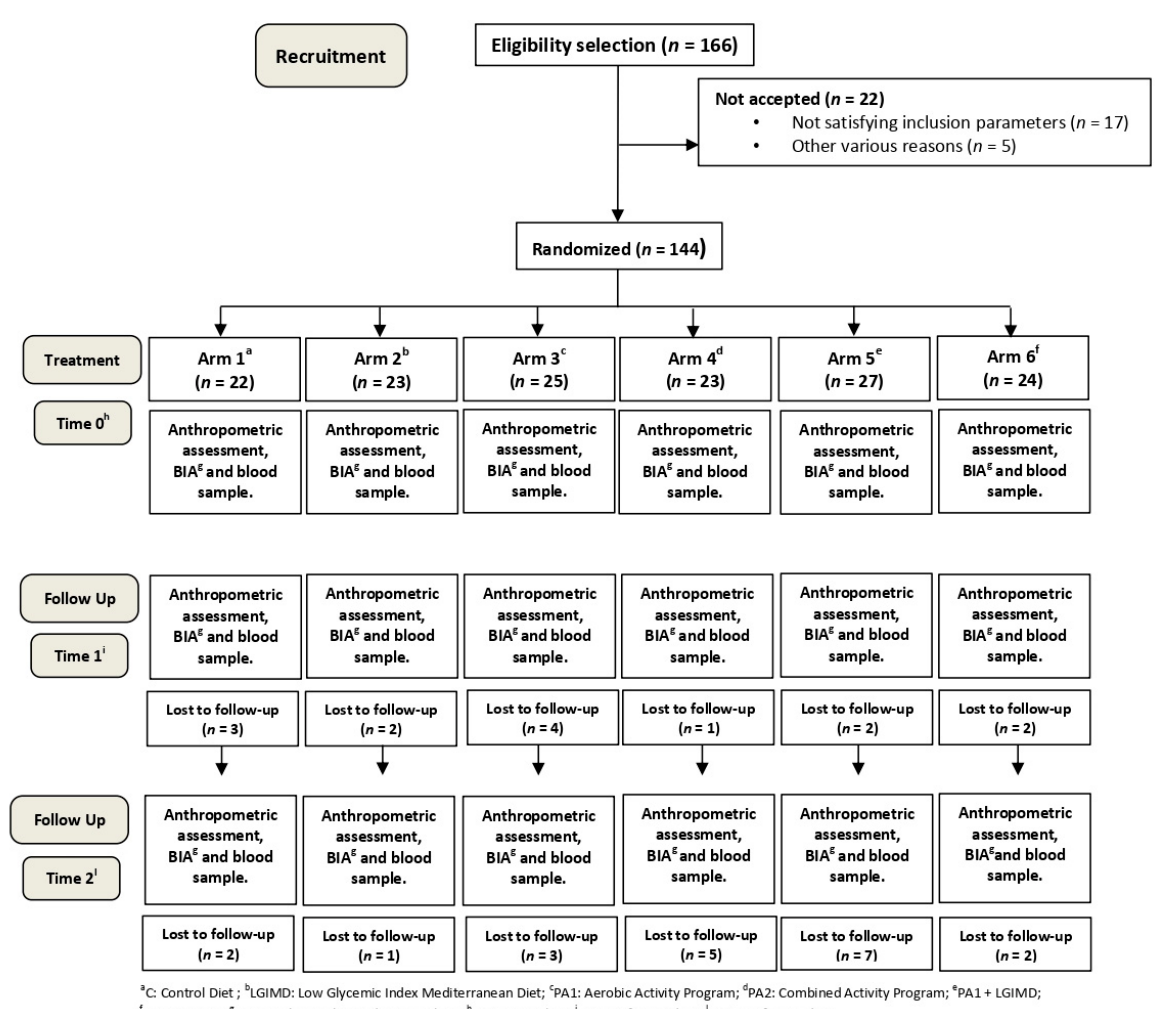
Figure 1. Flowchart of the study.